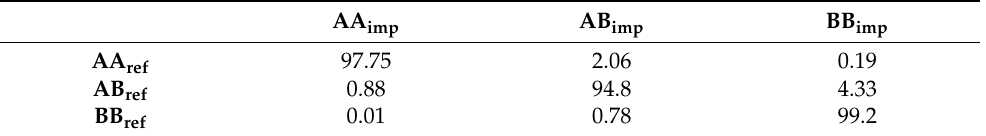
Figure 4. Plot of the first two principal components of the genomic relationship matrix of the sequence data and the imputed genotypes using the one- and two-step approaches. Table 3. Concordance rate in percentage between imputed and real genotypes for 224 Hanwoo and 6269 multi-breed animals in